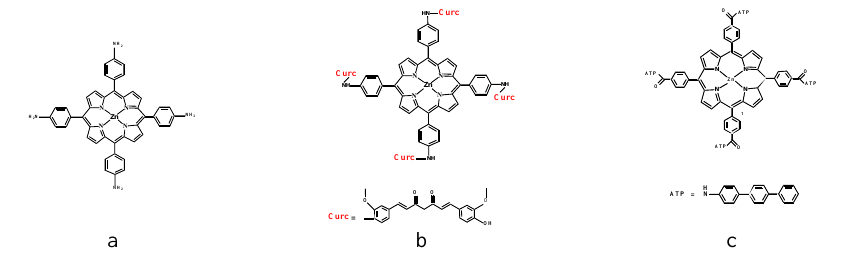
Fig. 1. Chemical structures of Zn-TAPP (a), Zn-TAPP–(Сurc) 4 (b) and Zn-TCPP-(ATP) 4 (c)